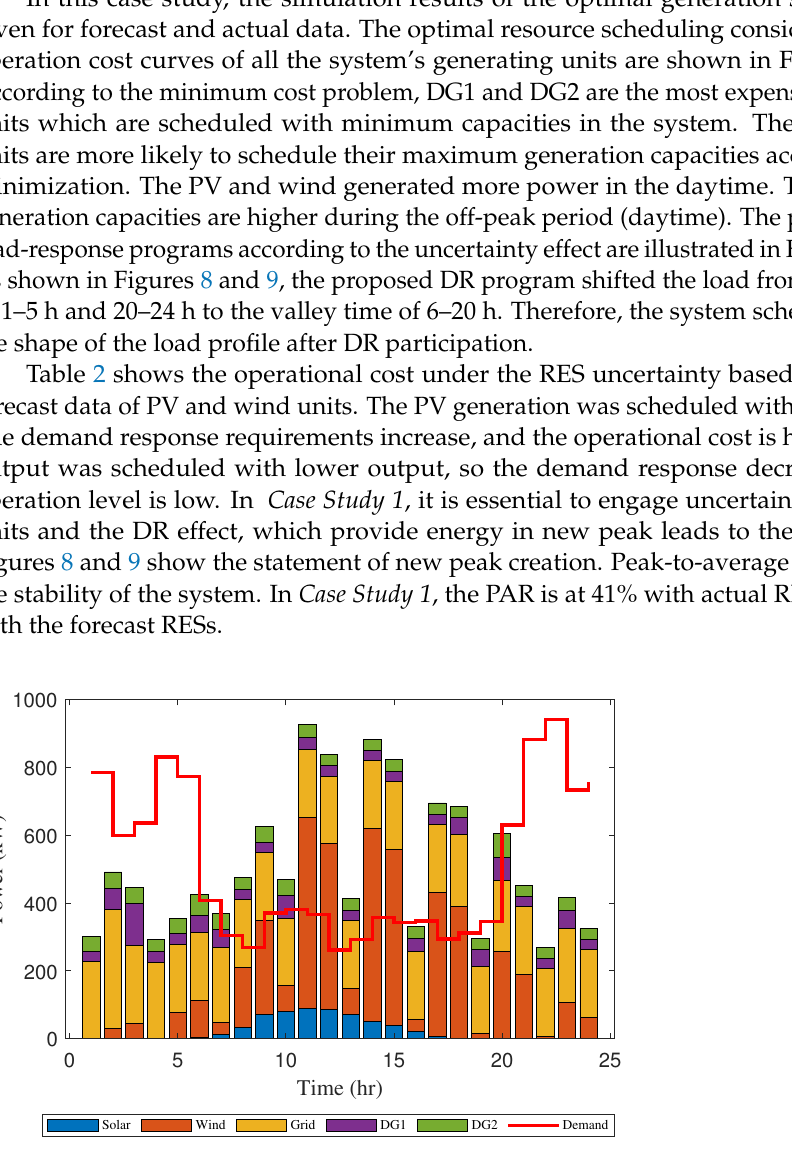
Figure 4. Optimal generation scheduling with PV and wind actual